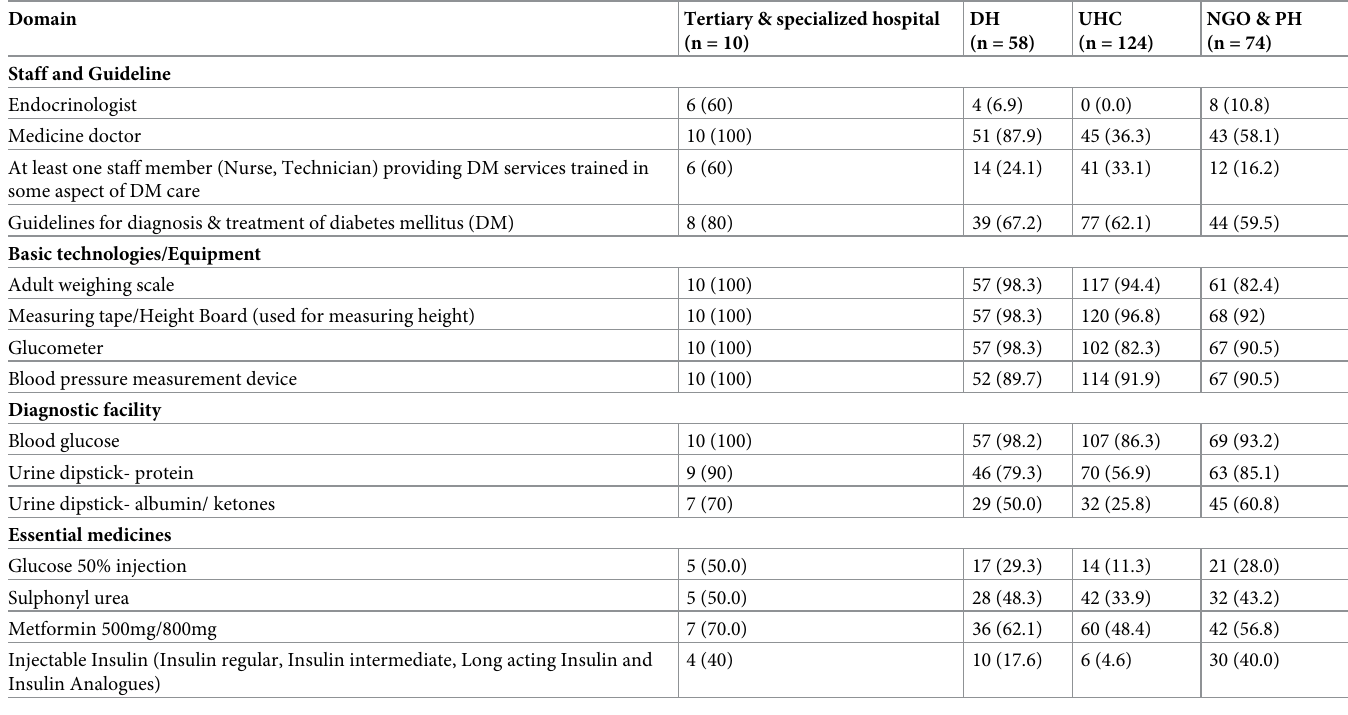
Table 3. Mean availability of DM service readiness indicators in different levels of facilities (n =